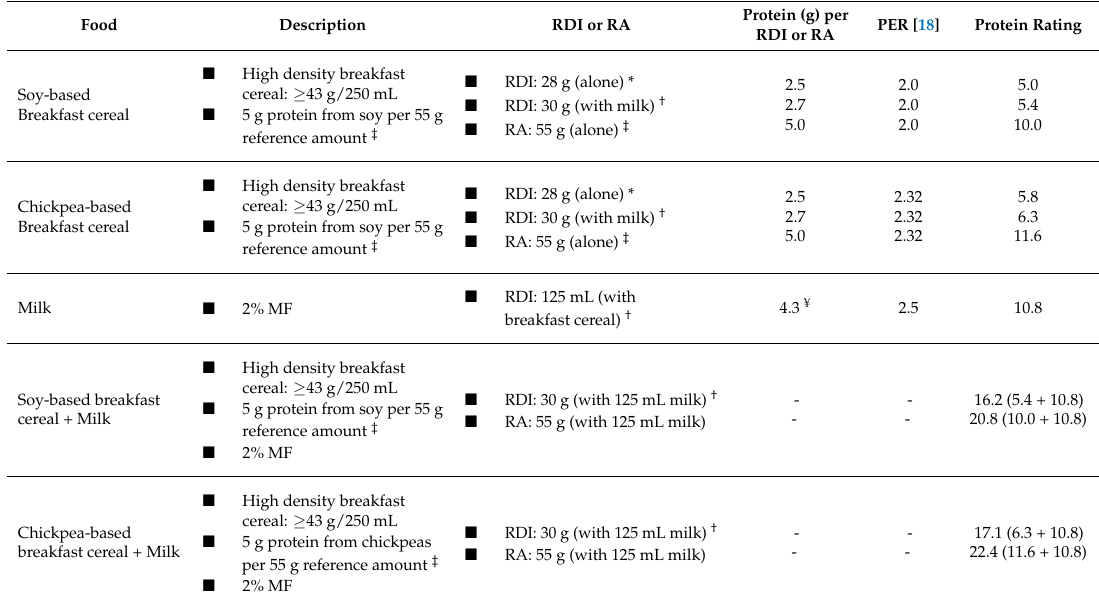
Table 1. Examples of the theoretical application of the PER and the use of the RDI vs. RA to determine the protein rating of specific foods in